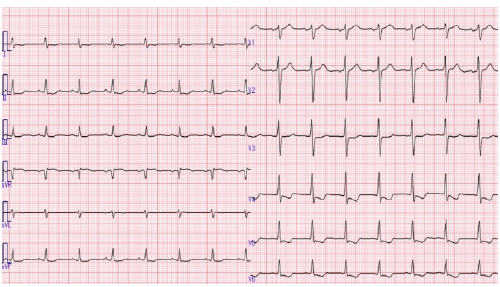
Figure 2: ECG shows downsloping ST depressions in left precordial and inferior